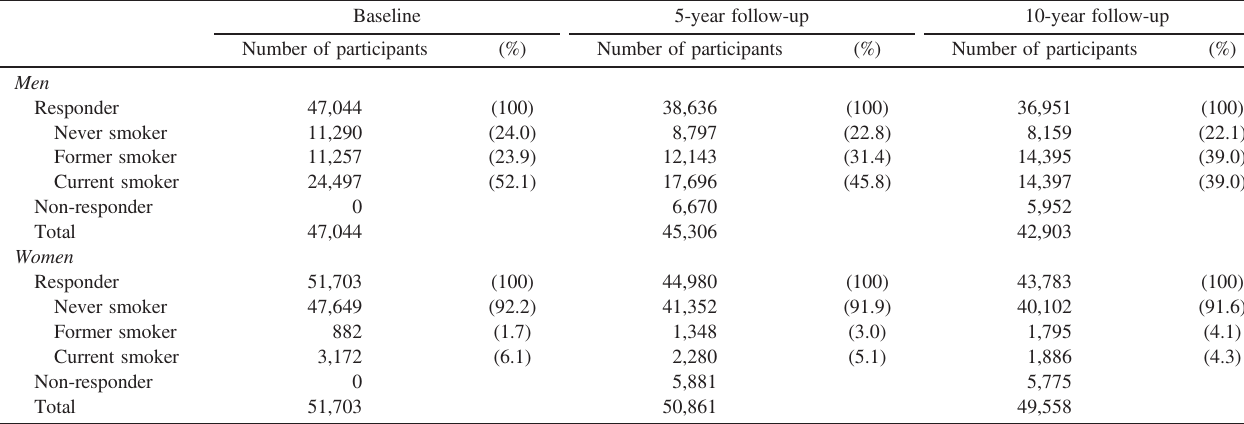
Table 1. Survey respondents on smoking status by survey period and